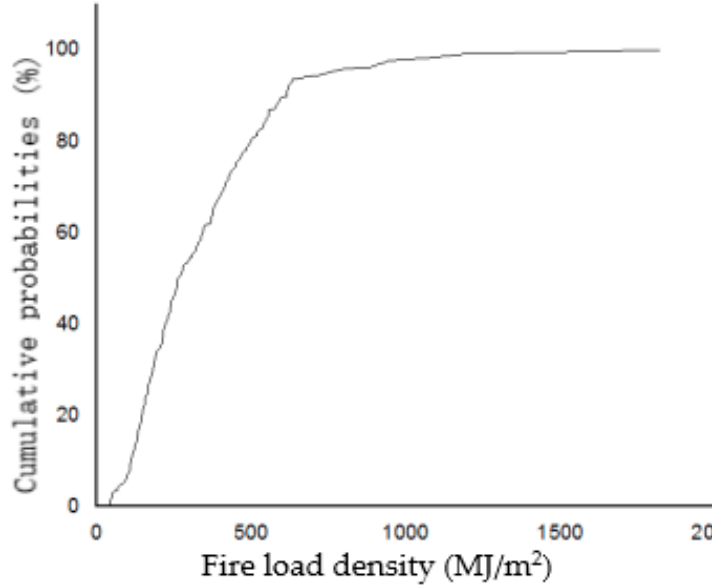
Figure 3. CDF of fire load density for high-rise residential buildings. Figure 3. CDF of fi re load density for high-rise residential buildings. 3.2. Ventilation Factor